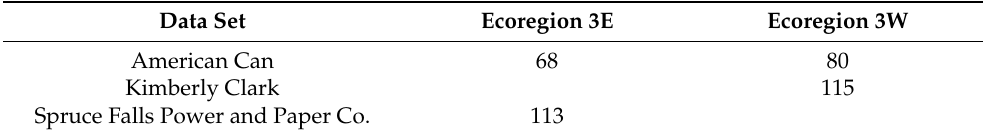
Table 4. Number of sample plots for each data set by ecoregions included in the study in northern Ontario, Canada. Data Set Ecoregion 3E Ecoregion 3W American Can Kimberly Clark Spruce Falls Power and Paper